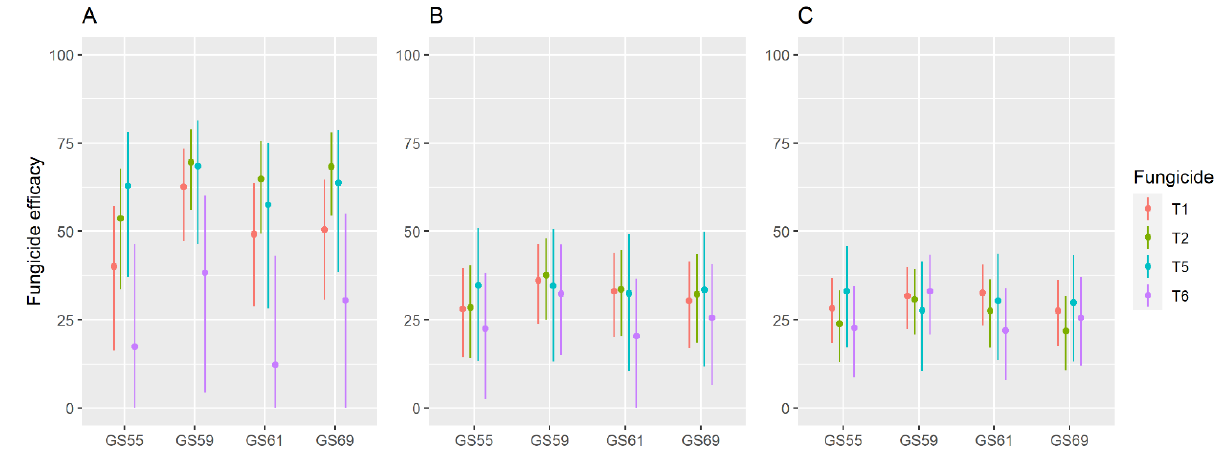
Figure 2. Efficacy of fungicide treatments applied at different wheat growth stages in reducing Fusarium Head Blight (FHB) incidence ( A ), FHB severity ( B ), and DON concentration ( C ) in EXP1. Fungicides were applied at GS55 (half of heading), GS59 (end of heading), GS61 (beginning of flowering), or GS69 (end of flowering). Fungicide treatments were grouped as: T1 (DMI), T2 (DMI + QoI), T5 (DMI + MS) and T6 (DMI + MBC) (Tables 1 and 2). Bars indicate 95% confidence